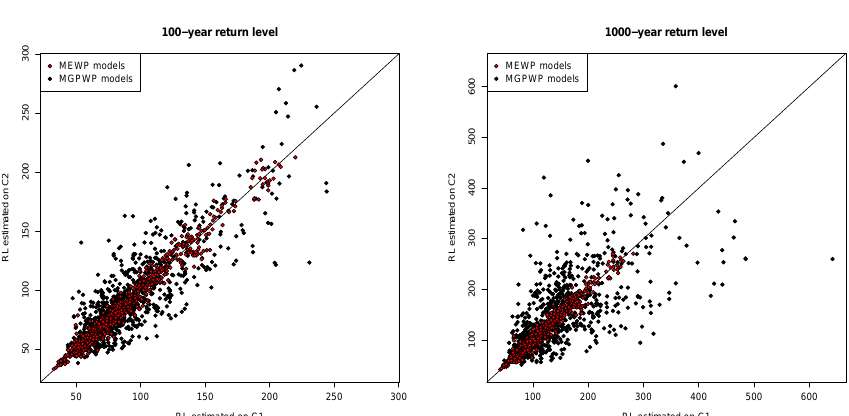
Figure 6. Same as Fig. 5 for MGPWP models.